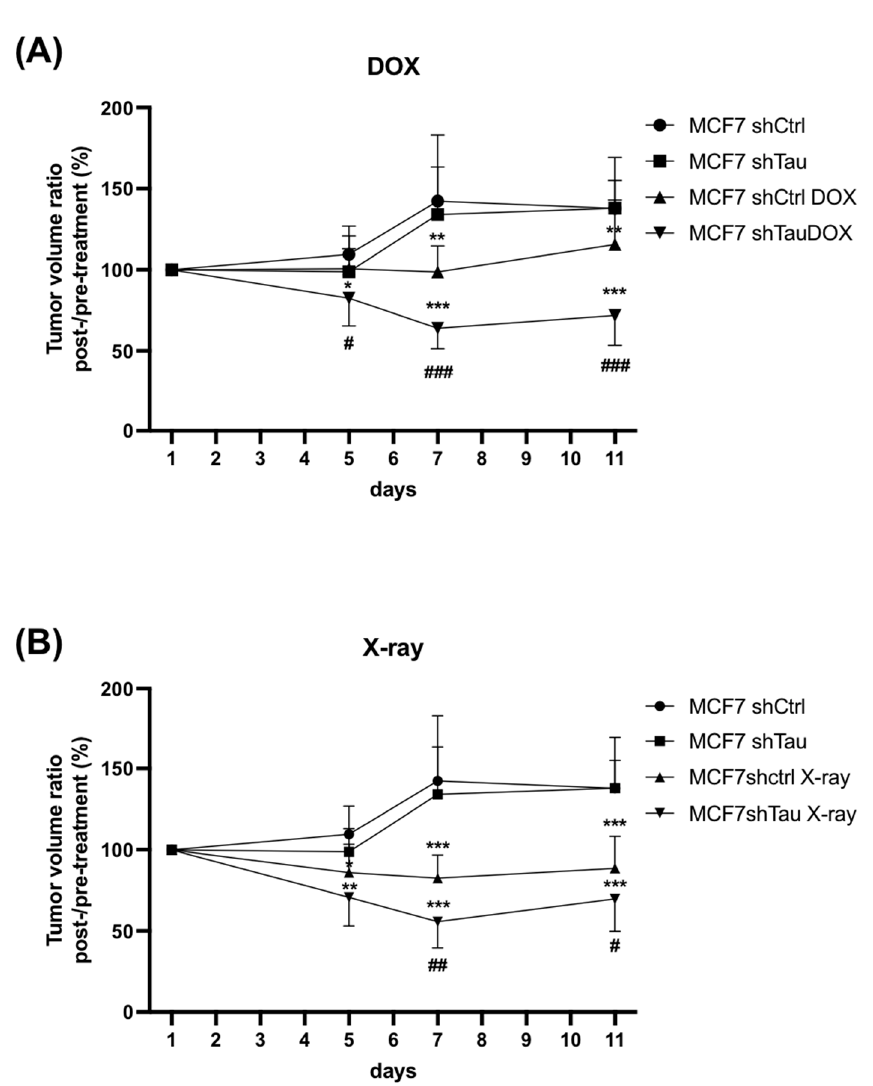
Figure 5. Tau depletion confers sensitivity to doxorubicin and X-rays in mice xenografts. MCF7 cells expressing either scramble (shctrl) or shTau were injected subcutaneously (5 mice per group),